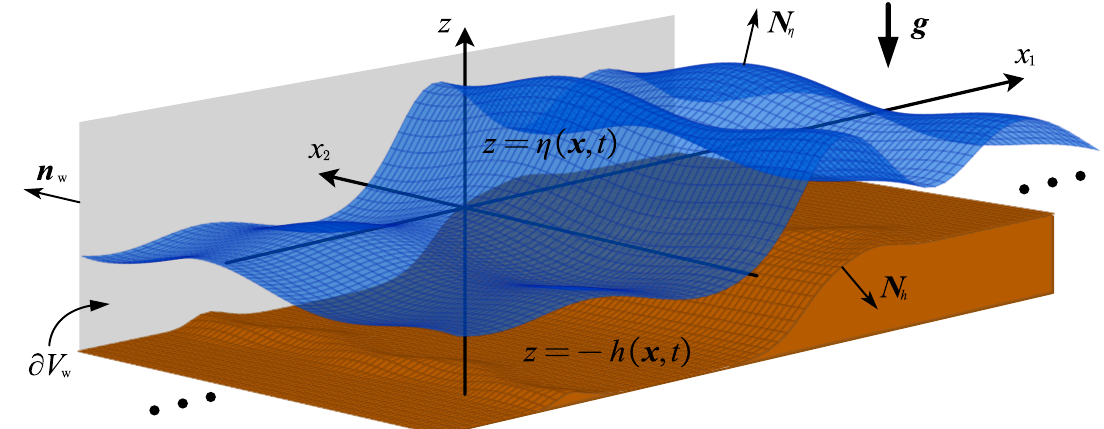
Figure 1. Geometrical configuration of the fluid domain V ( t )